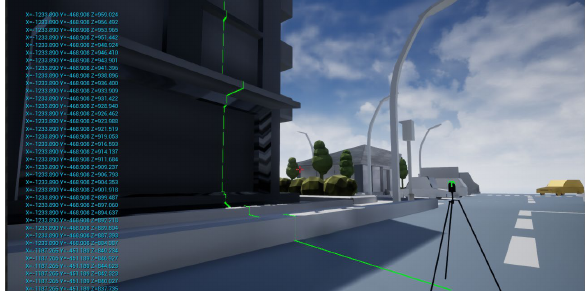
Figure 2: Prototype of the virtual scanner simulation